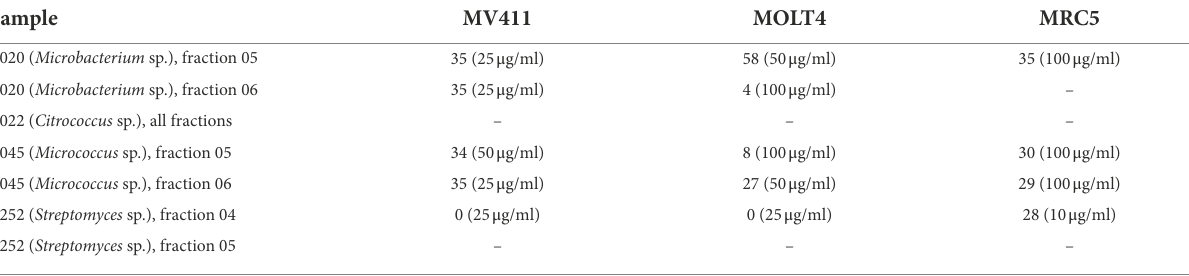
TABLE 5 Results of the anti-cancer screening for the fractionated resin extracts, given are the reduced cell proliferation in percent of the control (100%/ normal growth) for the respective test-concentration of extract fractions, which is given in parenthesis. Sample